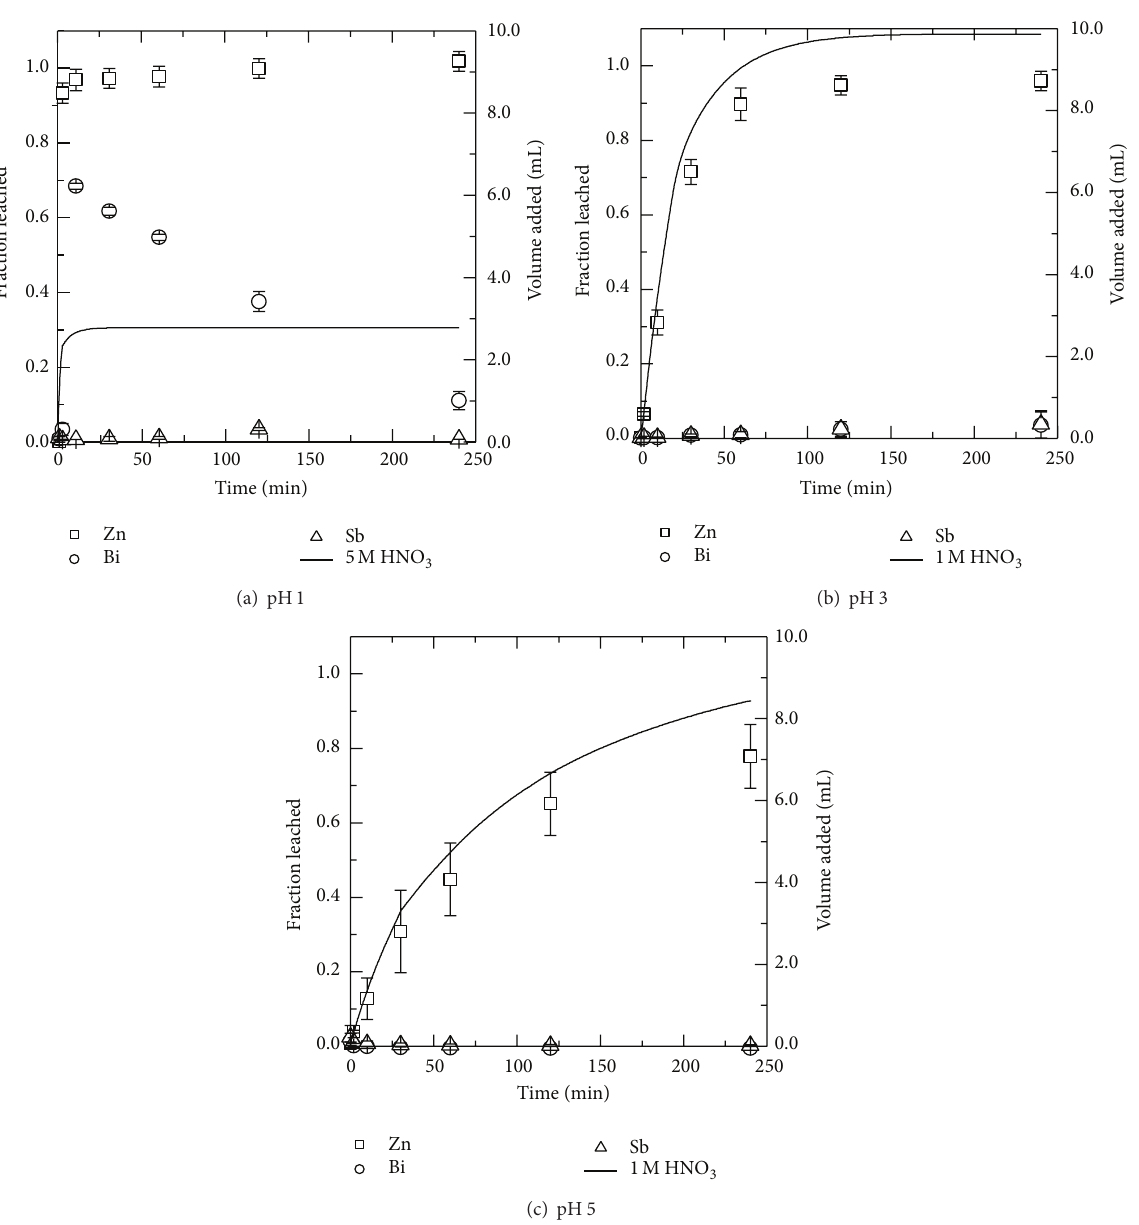
Figure 5: The leached fraction as given by the left ordinate for zinc ( ◻ ), bismuth ( I ), and antimony ( 󳵻 ) from MOV in (a) pH 1, (b) pH 3, and (c) pH 5 solutions. The volume of nitric acid (HNO 3 ) added is shown as a solid black line corresponding to the right